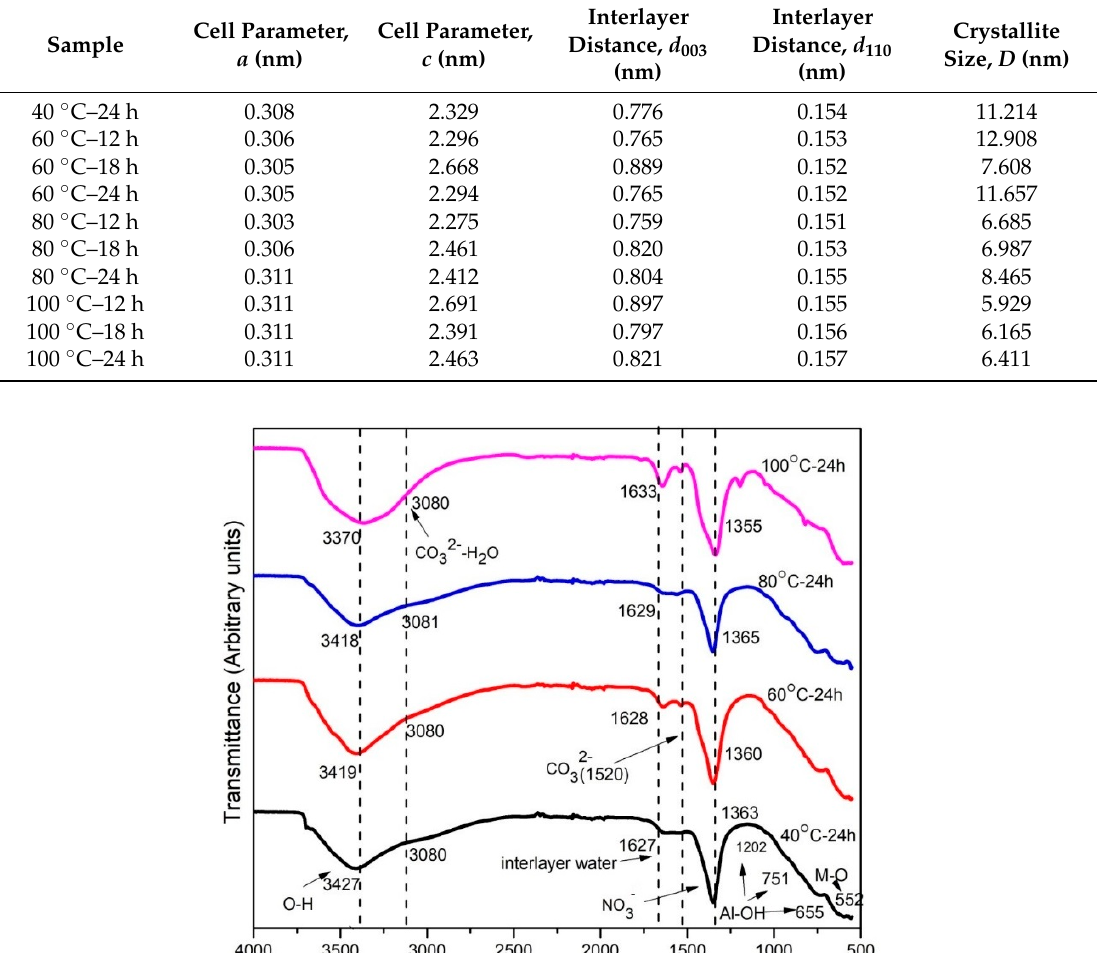
Table 1. Cell parameters and sizes of the coherent domains determined for the Mg − Al layered double